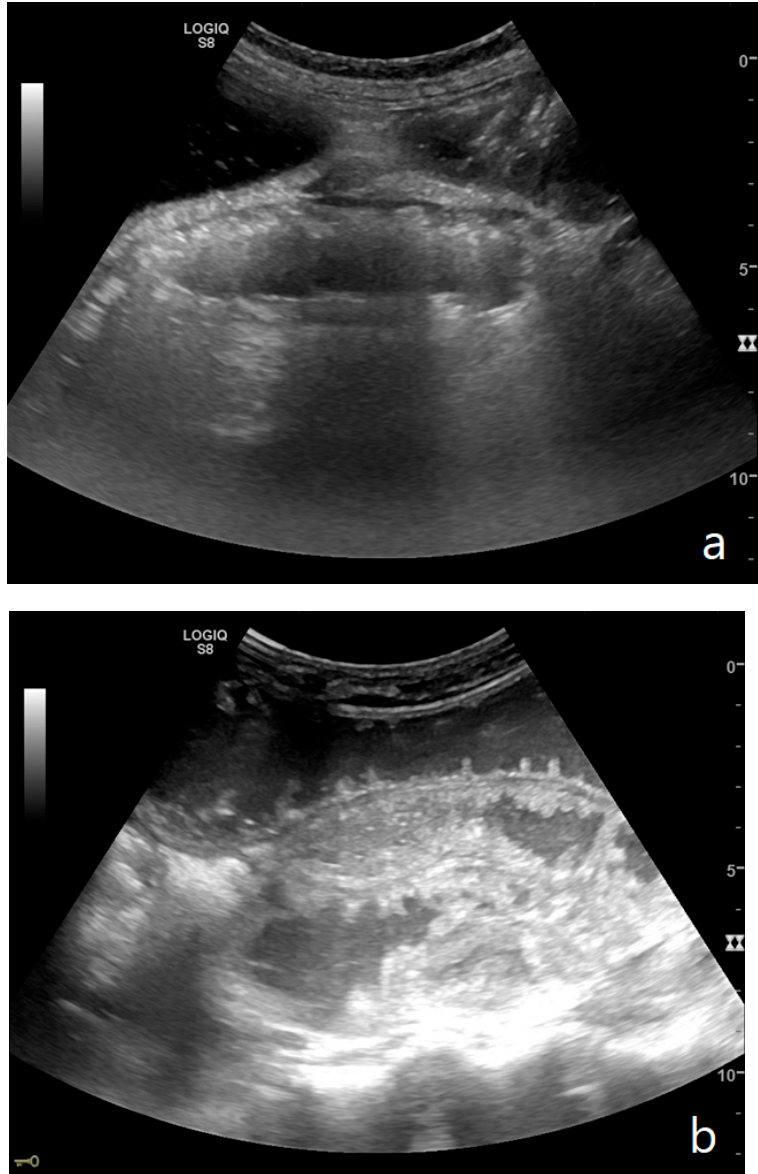
Figure 5. A complicated SBO presenting fluid-filled bowel loops with thickened walls with a stratified echo pattern ( a ) and thickened valvulae conniventes ( b ). Free fluid in the abdominal cavity was detected ( b ). Tail comet artifacts for air-fluid levels are visible ( a ). At the time of surgery, the bowel loop was necrotic.